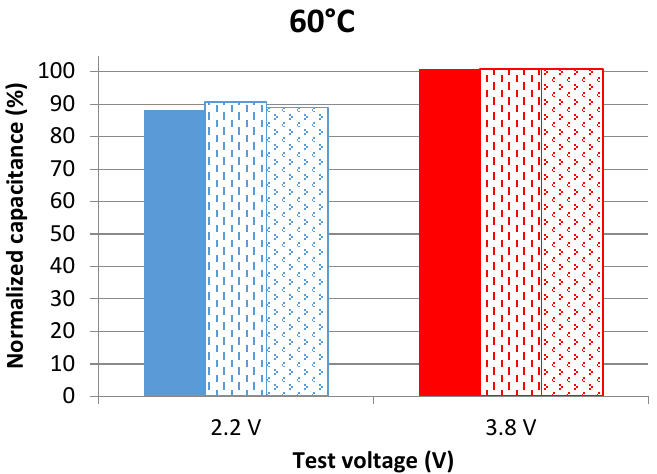
Figure 3. Capacitance evolution of cells aging at 2.2 V and 3.8 V at 60 °C after 109 days of calendar aging. The results are found from measurements in the time domain at 25 °C.